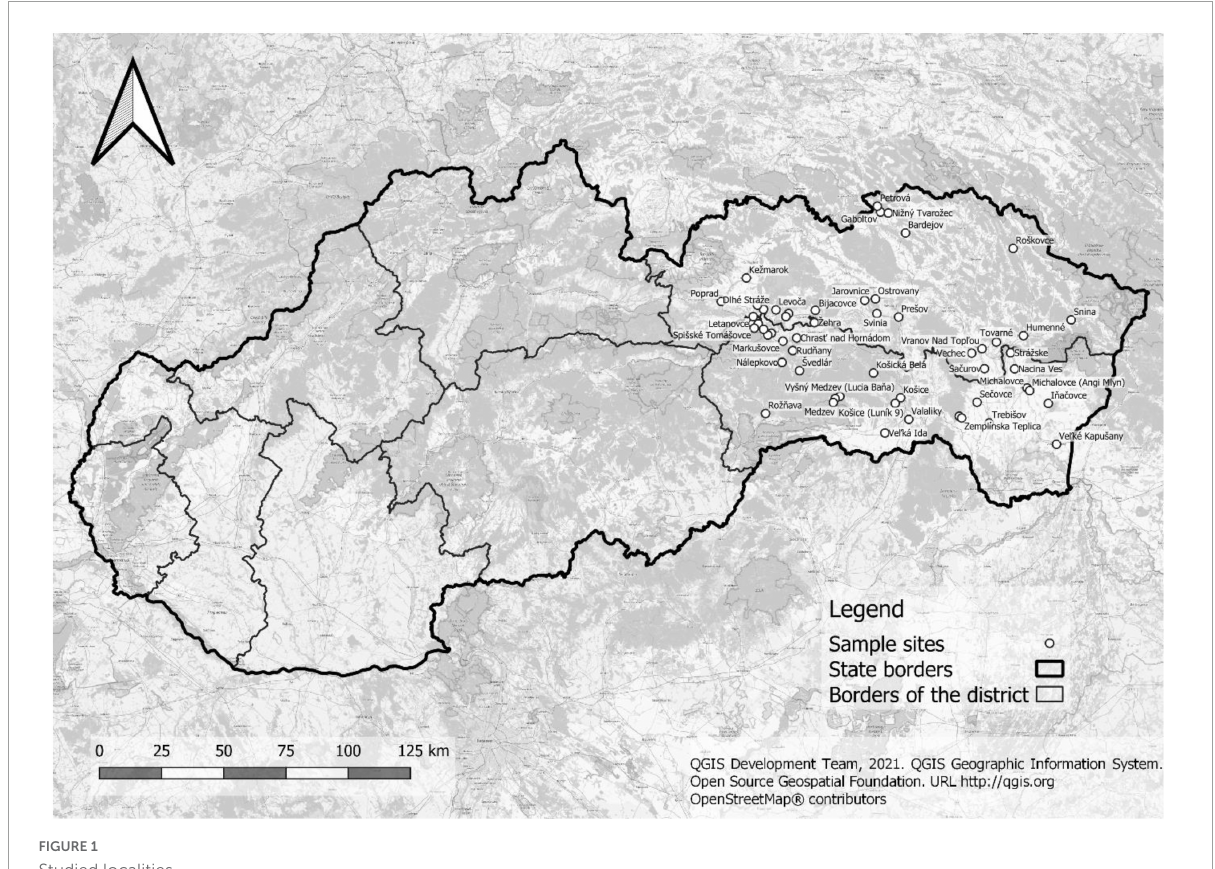
FIGURE1 Studied